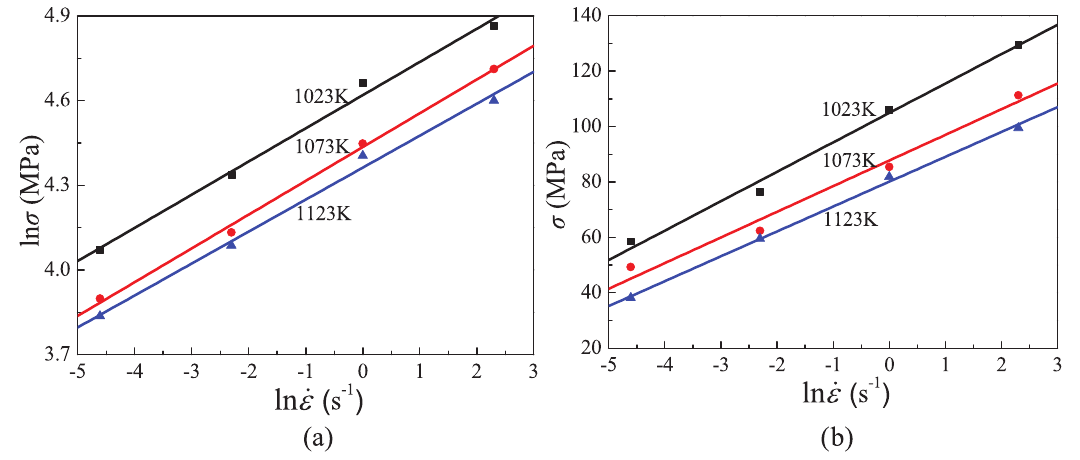
Fig. 4: Relationships between strain rates and peak stresses: (a) ln s and e  ln ; (b) s and e 